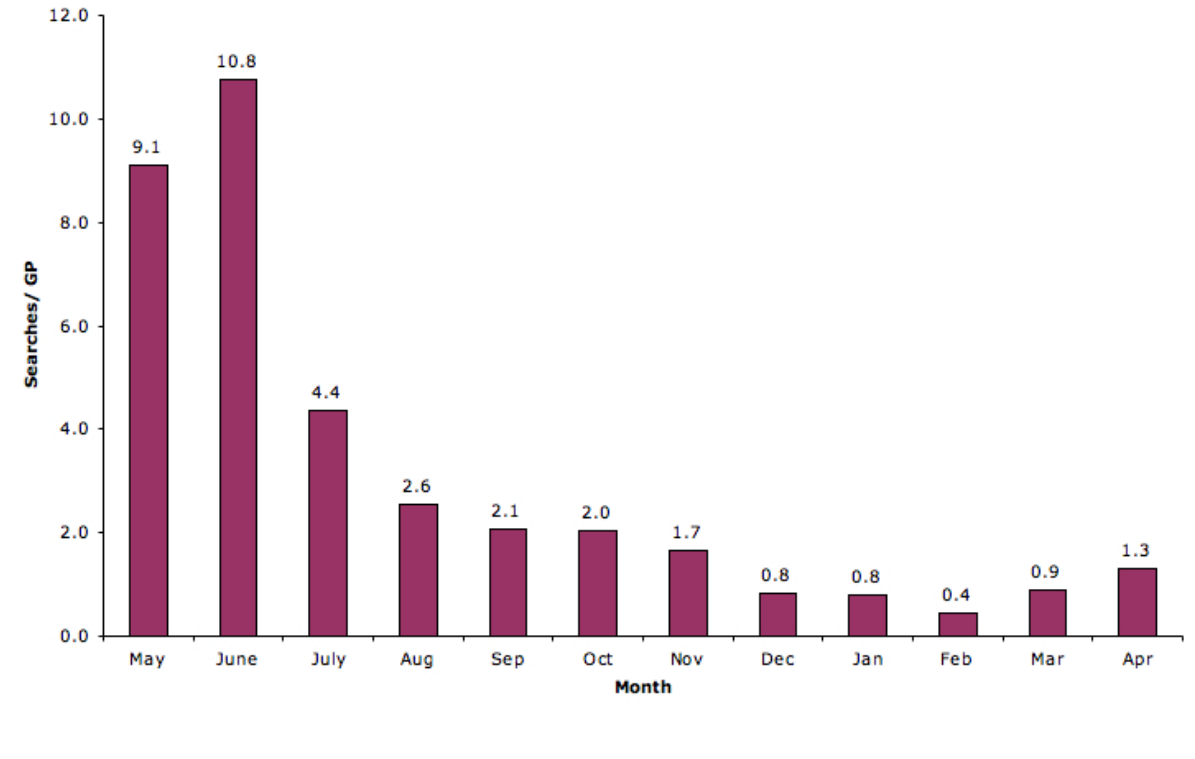
Figure 3. Percentage of GPs conducting QC searches over the 12-month study period, by number of searches (N = 59